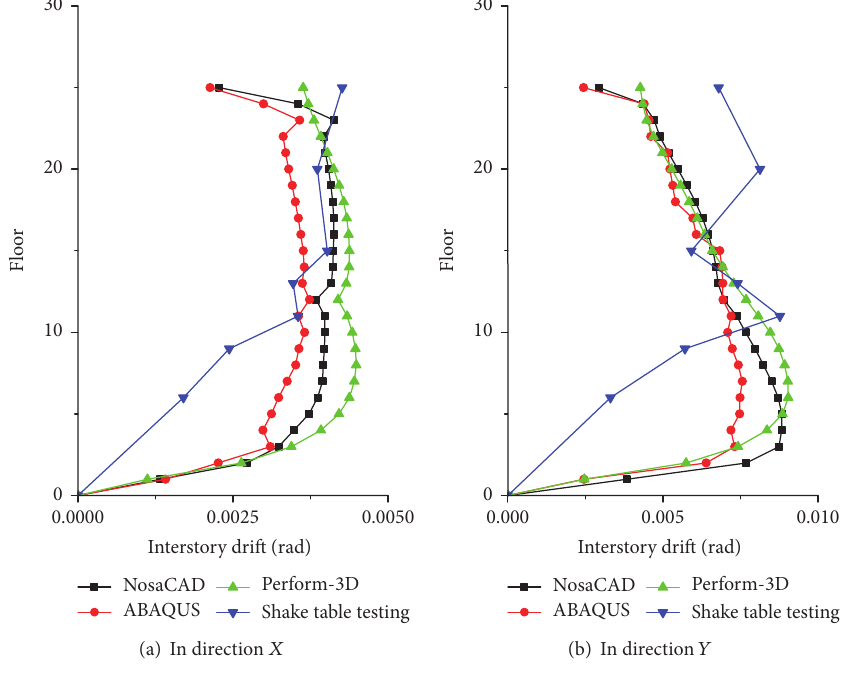
Figure 20: Interstory drift envelopes under rare intensity 7